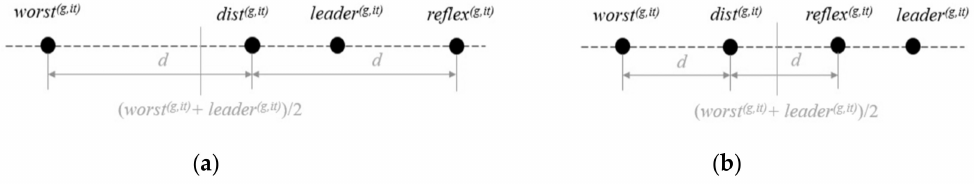
Figure 7. Reflex search in the SWA algorithm: ( a ) exploration, ( b ) exploitation.